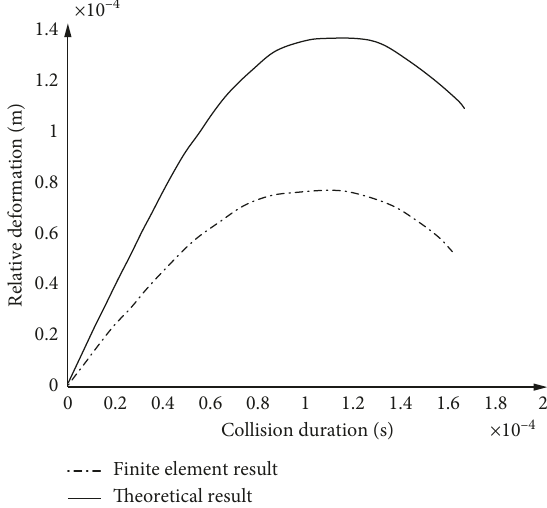
Figure 10: Curve of collision duration-relative deformation (tangential velocities of two balls are 0.5 m/s and − 0.5m/s).